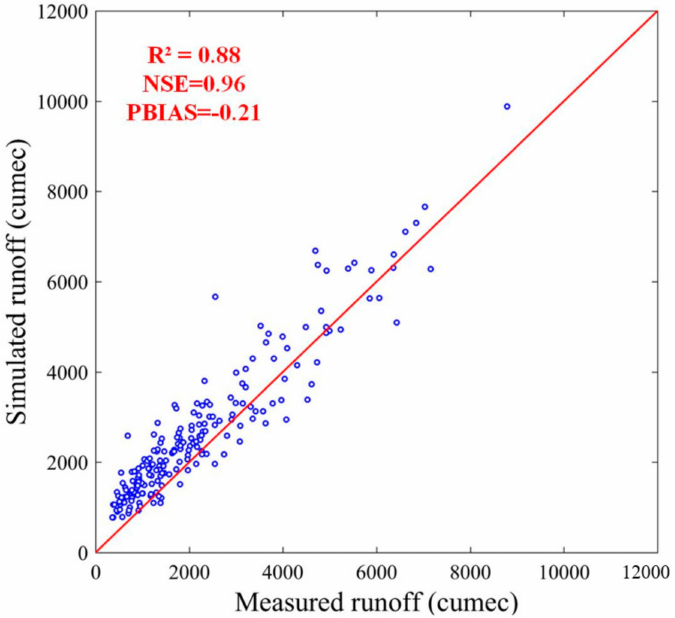
Figure 5. Scatter plot of simulated and measured monthly runoff of Waizhou station during calibra- tion period. Note: the cumec represents the unit of runoff in cubic meters per